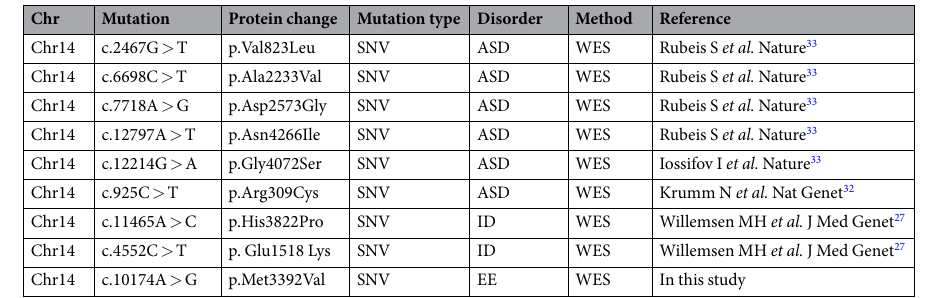
Table 2. The shared de novo mutations of DYNC1H1 among ASD, ID and